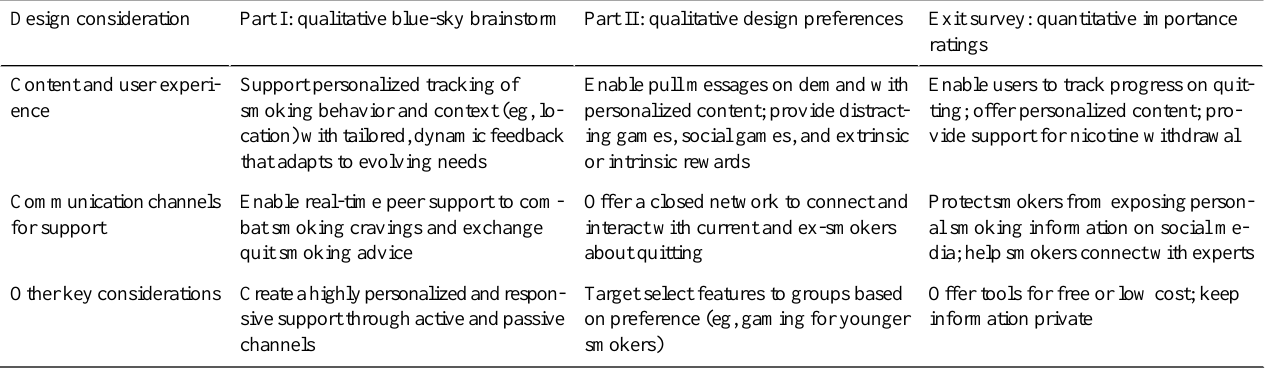
Table 3. Synthesis of preferred design considerations across assessment